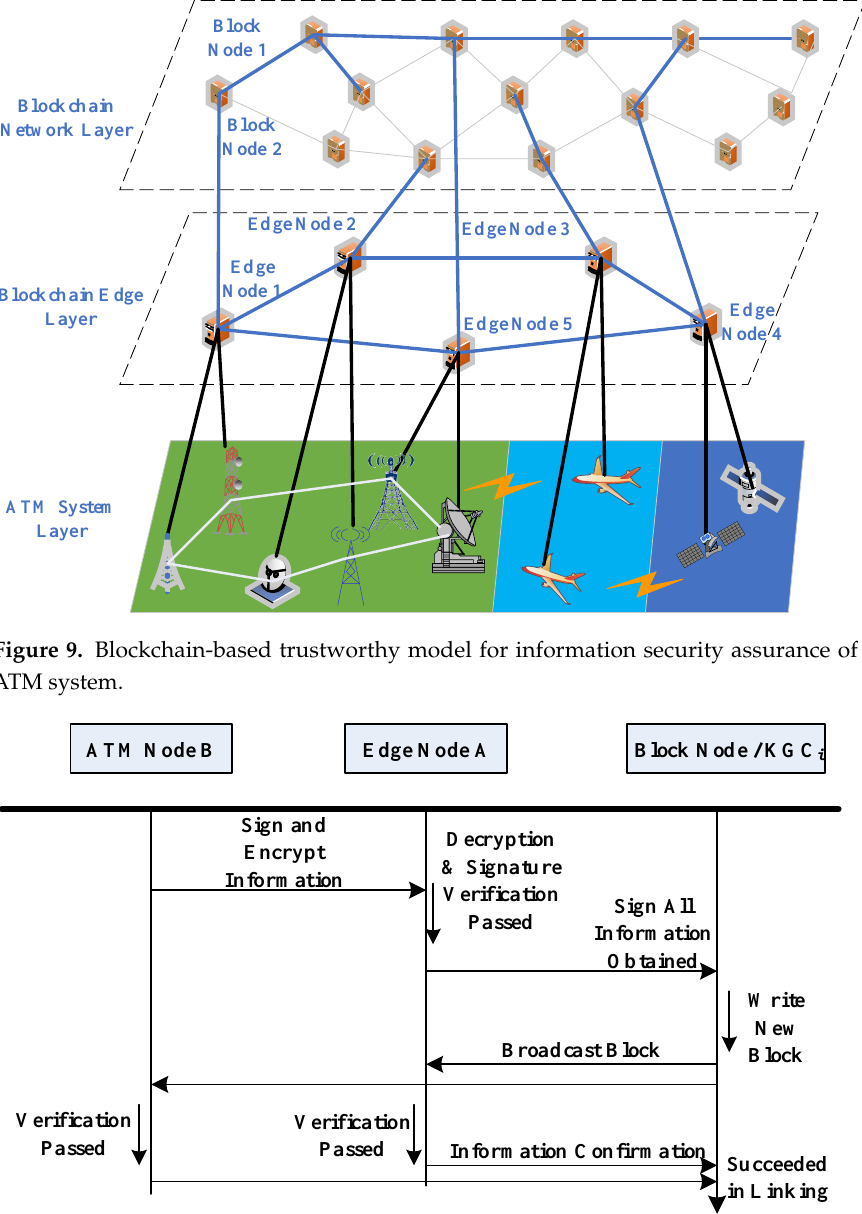
Figure 10. Block into blockchain